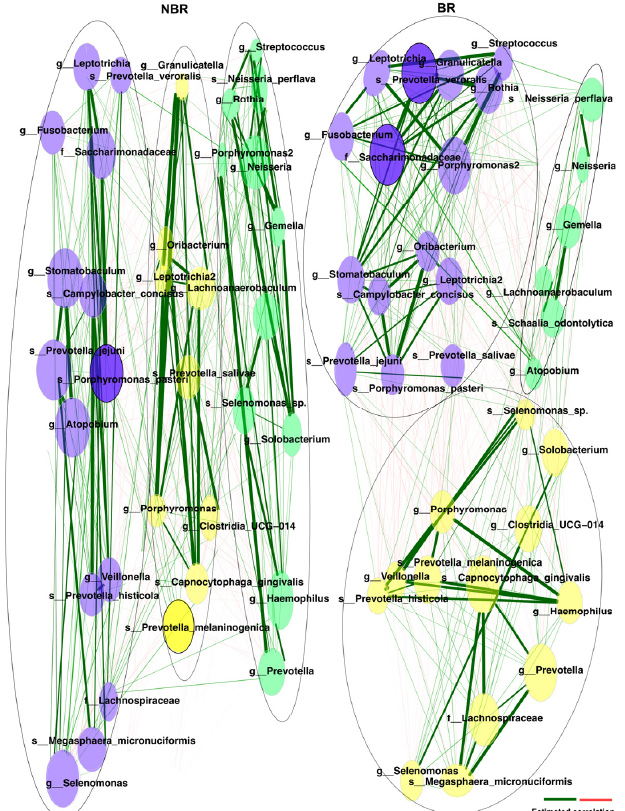
Figure 8. Dissimilarity-based networks were generated to compare community dynamics of the oral microbiota of BR vs. NBR samples. Green lines estimate positive correlations and red lines refer to the negative correlations. The thickness of lines shows the strength of correlation. The node colors represents different microbiota clusters: purple—cluster 1, yellow—cluster 2 and green—cluster 3. The total number of OTUs (operational taxonomic units) identified in the 70% core- oral microbiota was 34.